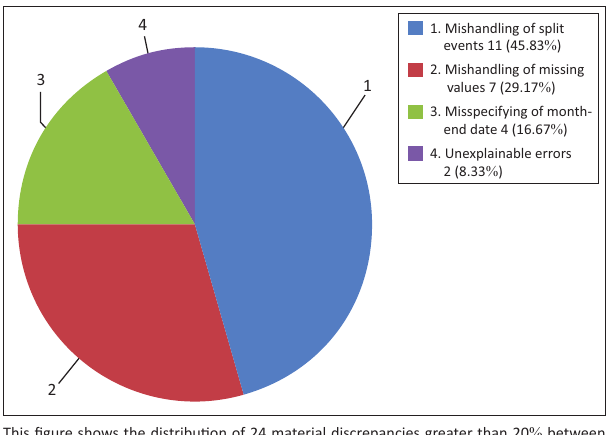
FIGURE 1: The distribution of material discrepancies greater than 20 % between DataGuide and KisValue by the source of discrepancy.